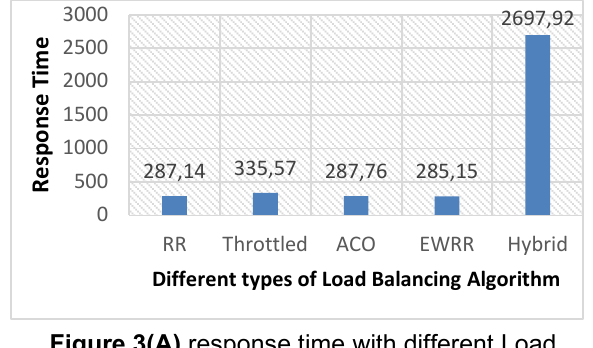
Figure 4(B) response time with different Load balancing Algorithm Using Experiment